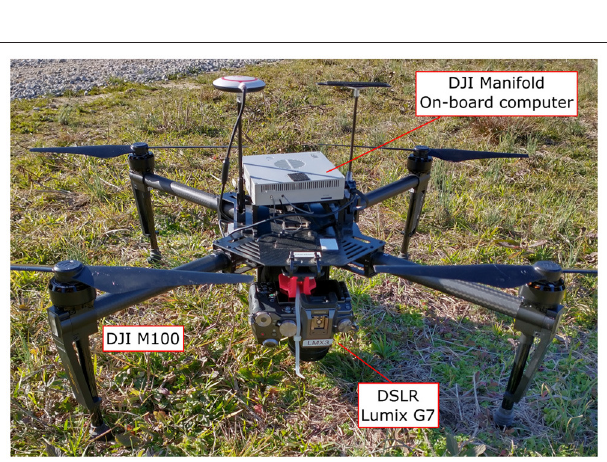
FIGURE 2 | Equipment used for image collection. Unmanned Aerial Vehicle, DJI Matrice M100 Pro, equipped with a Manifold onboard computer and a Panasonic Lumix DMC-G7 DSLR camera as imaging